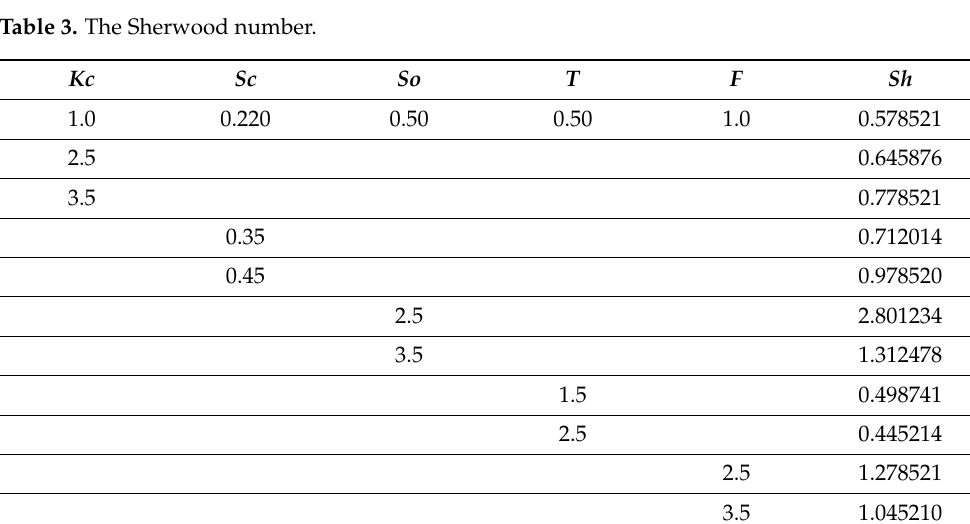
Table 3. The Sherwood number.